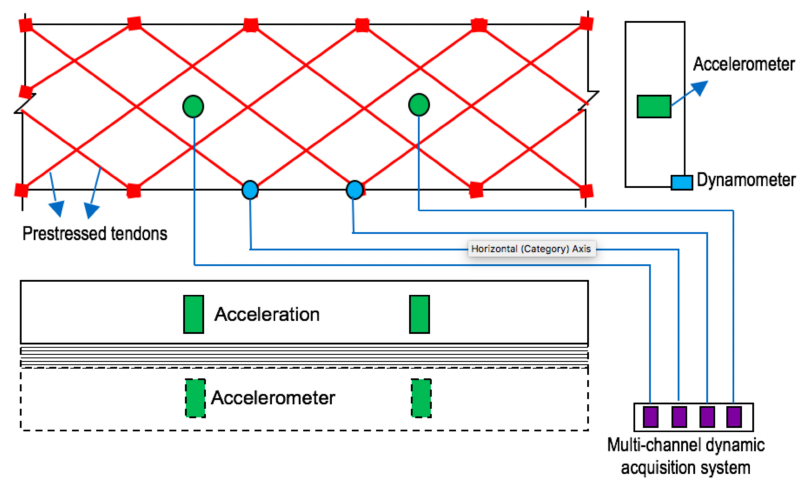
Figure 11. Schematic multi-views of the inclined prestressed concrete pavement monitoring